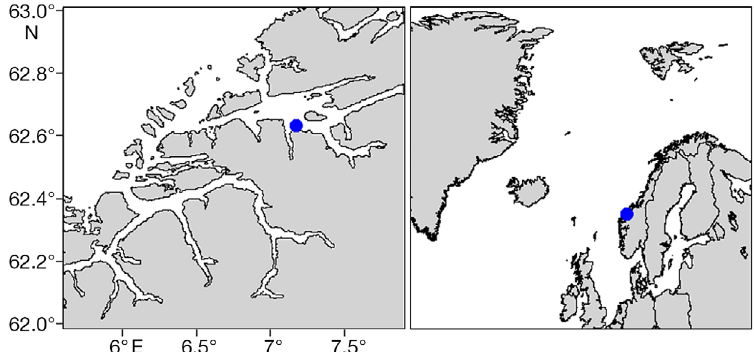
Fig. 1. Farming locality in Gjermundnes (blue dot), Møre and Romsdal county, Norway